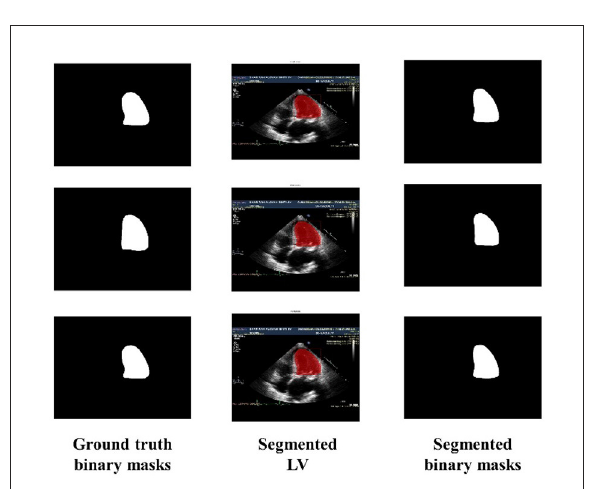
FIGURE7 Ground truth binary mask, segmented LV, and corresponding segmented binary masks (using 4,000